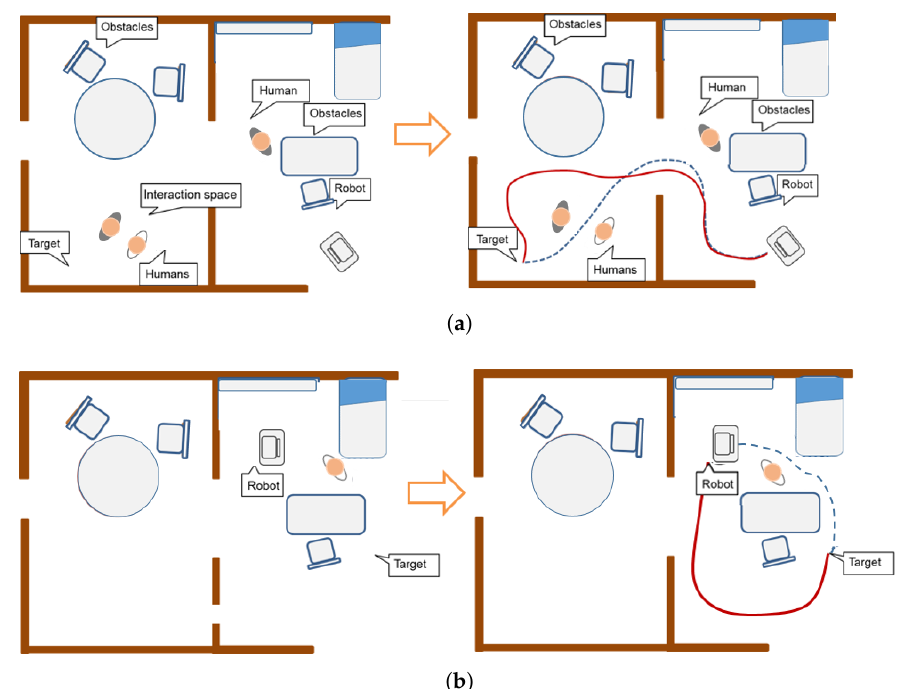
Figure 8. Two different everyday situations in caregiving centers: ( a ) left: a scenario where two people are interacting each other; right: red path is the only one accepted by people according to social conventions; ( b ) left: a scenario where the caregiver is interacting with the stretcher; right: red path shows the socially accepted